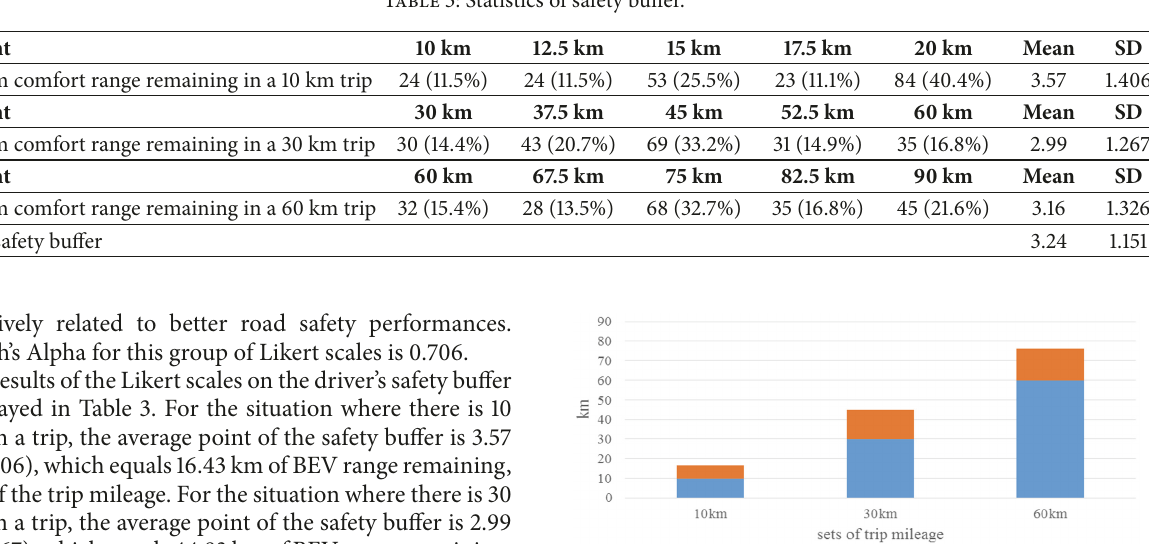
Table 3: Statistics of safety buffer.